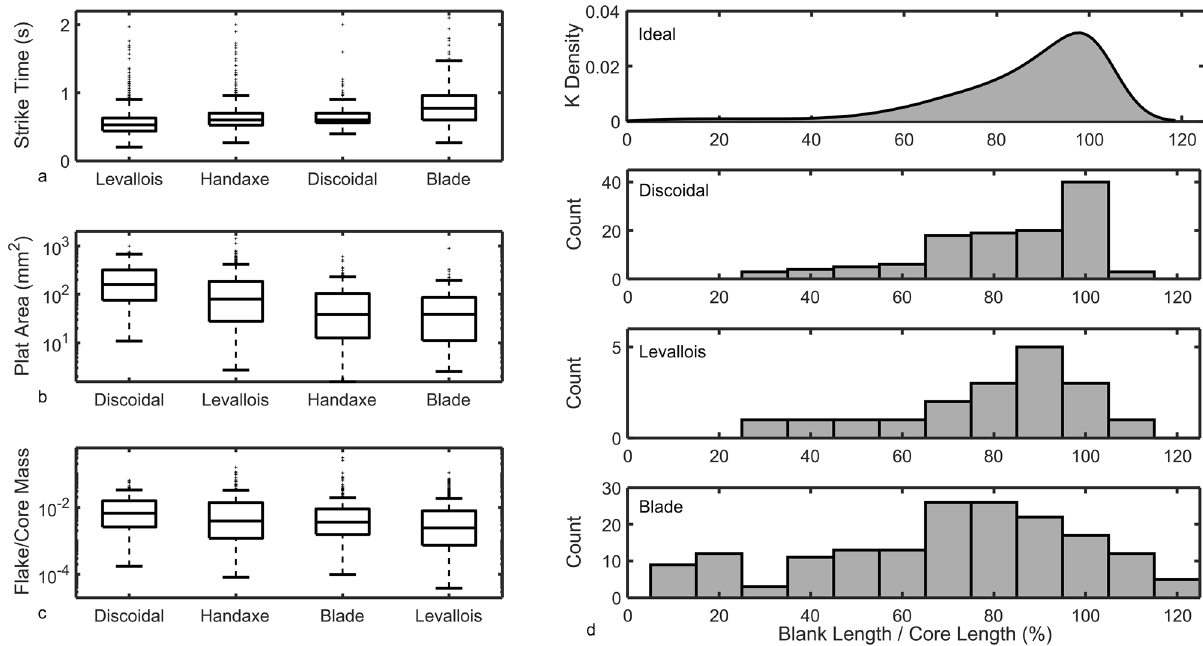
Figure 2. Results of the proxy measures for knapping difficulty. ( a ) Boxplot of the strike times (seconds) taken for Levallois (N = 1757, median = 0.53s), handaxe (N = 649, median = 0.60s), discoidal (N = 250, median = 0.60s), and prismatic blade (N = 469, median = 0.77s) knapping. ( b ) Boxplot of the flake platform area values for the discoidal (N = 150, med = 160.08mm 2 ), Levallois (N = 543, med = 79.91mm 2 ), handaxe (N = 175, med = 38.27mm 2 ), and prismatic blade (N = 184, med = 38.53mm 2 ) flakes. ( c ) Boxplot of individual flake mass versus total flake mass from the same core for the discoidal (N = 165, med = 0.0067), handaxe (N = 357, med = 0.0039), prismatic blade (N = 289, med = 0.0036), and Levallois (N = 698, med = 0.0024) iterations of this experiment. A logarithmic scale on the y-axis in b and c is used to better display the positively skewed data. ( d ) Histograms showing the percent of blank length to core length for the discoidal (N = 118, med = 90), Levallois (N = 18, med = 85) and prismatic blade (N = 169, med = 70)